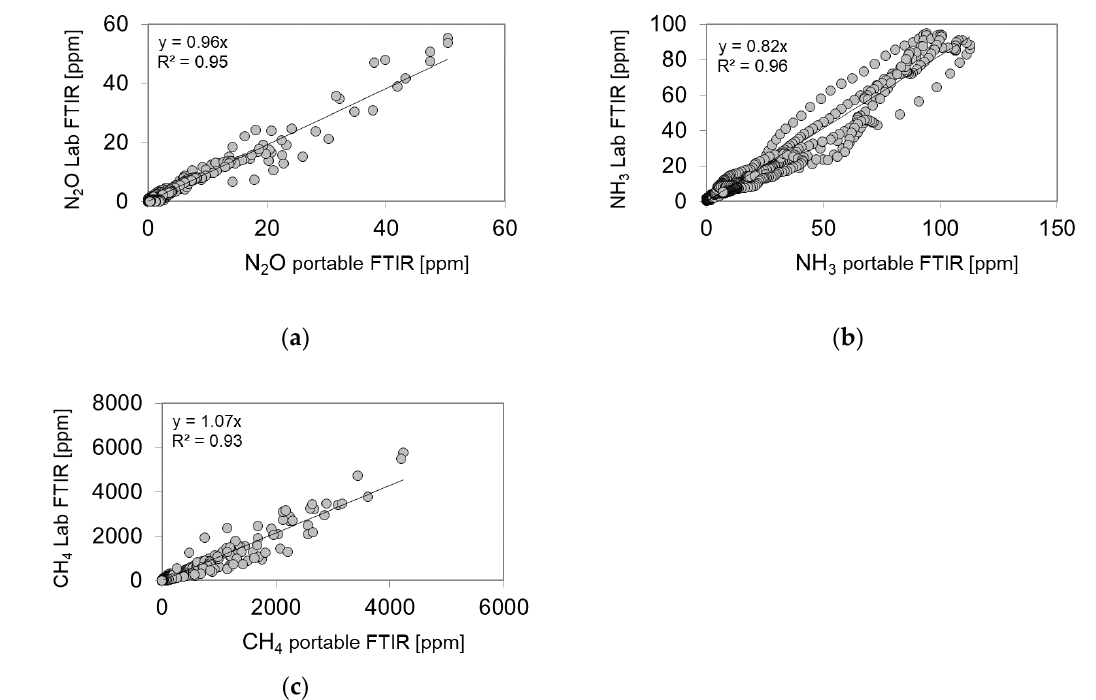
Figure 2. Correlation of ( a ) N 2 O, ( b ) NH 3 , and ( c ) CH 4 measured using the portable FTIR and the laboratory-grade instrument. The measurements NH 3 , N 2 O and CH 4 were compared to those of the MKS Multigas analyzer 2030-HS during a WLTP test of DV1.